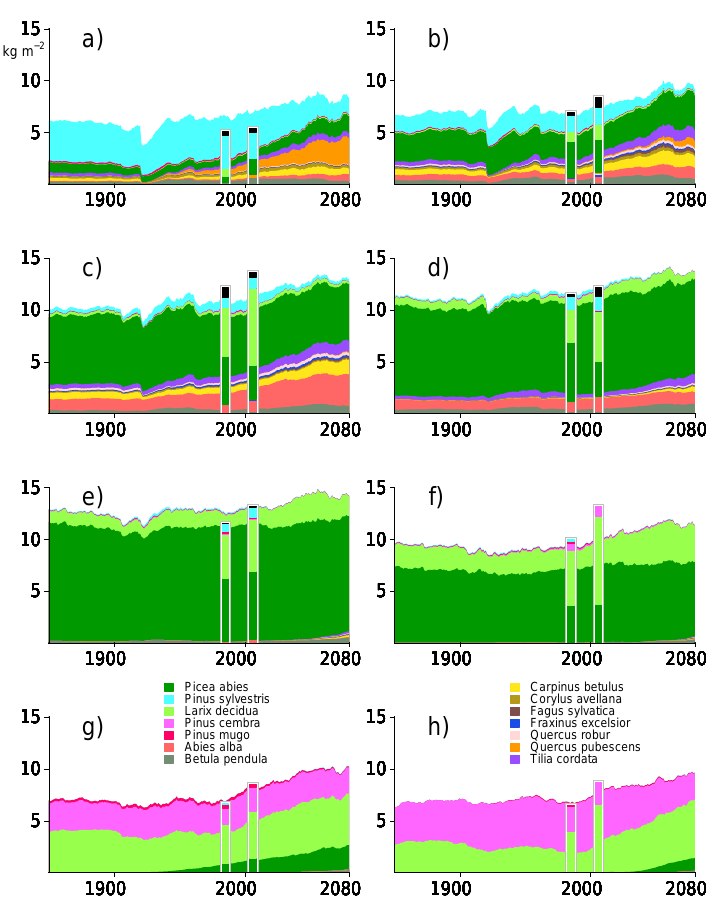
Fig. D3. Single-species carbon mass with LPJ-GUESS using 400 replicate patches. Development of carbon mass until 2080. Bars indicate the NFI1 (1985) and NFI3 (2006) data. Black bar sections stand for broad-leaved species that were not modeled.